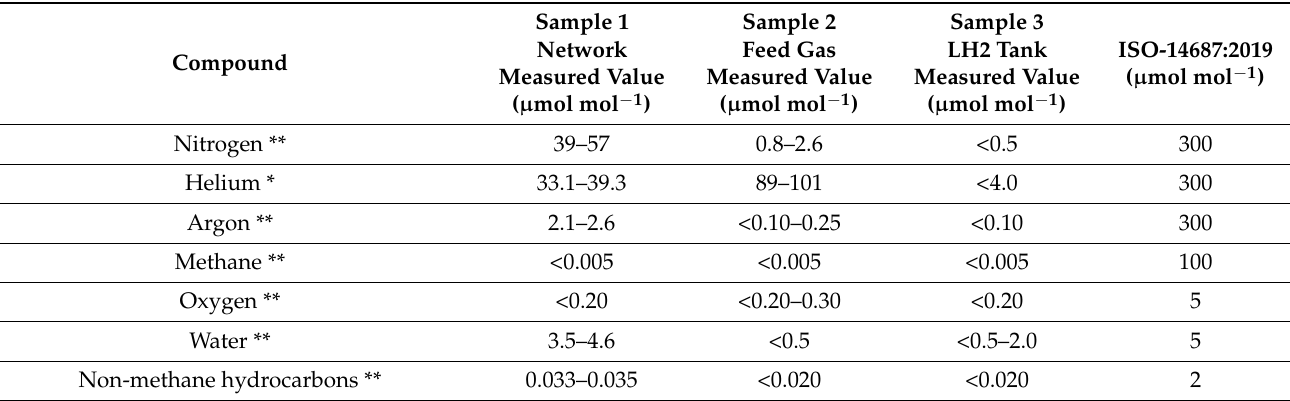
Table 4. Results of hydrogen gas quality at different points of the liquefaction process according to the ISO-14687:2019 list of contaminants. Where possible, minimum–maximum values are shown considering expanded uncertainties. Measurements below the limit of detection denoted by